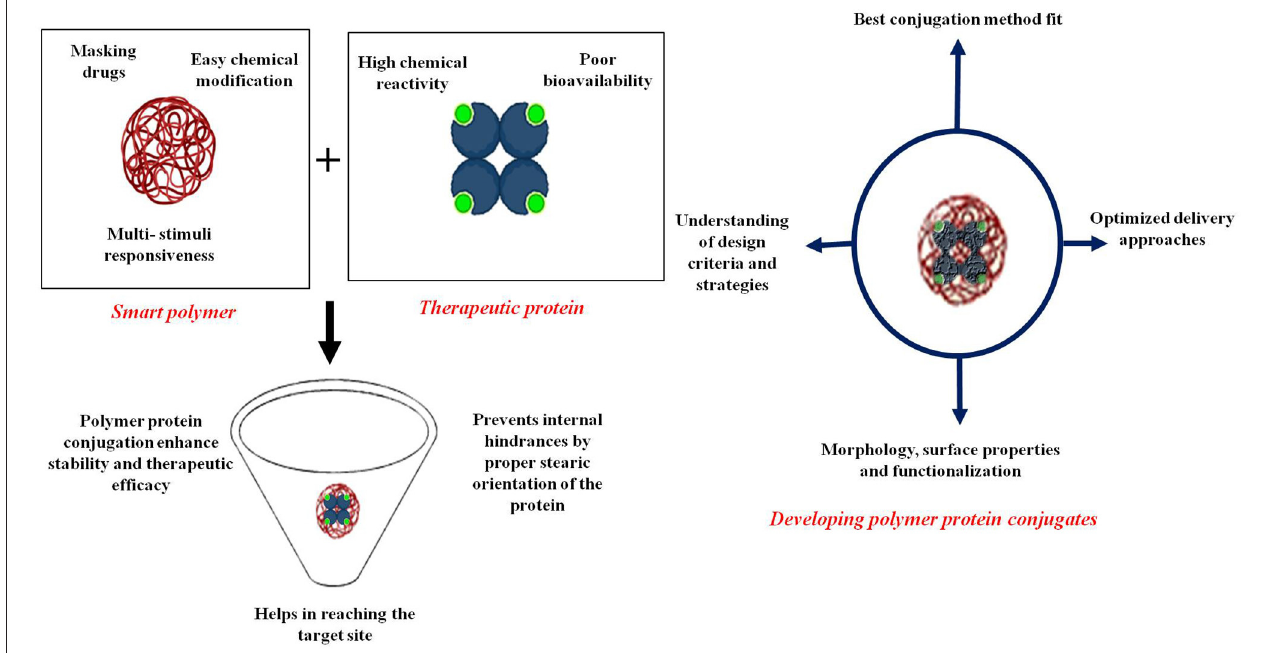
FIGURE 2 | Applications of various protein-polymer conjugates in the wide spectrum of biomedical fields (created with biorender).